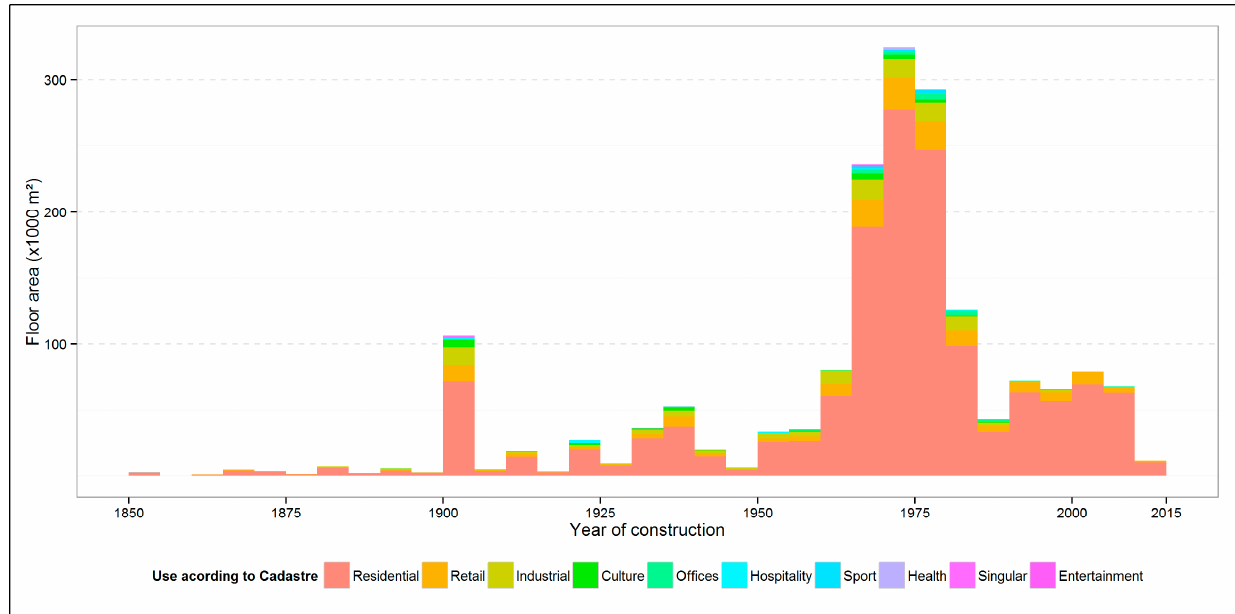
Figure 23. Weighted histogram of built area per year of construction and use.